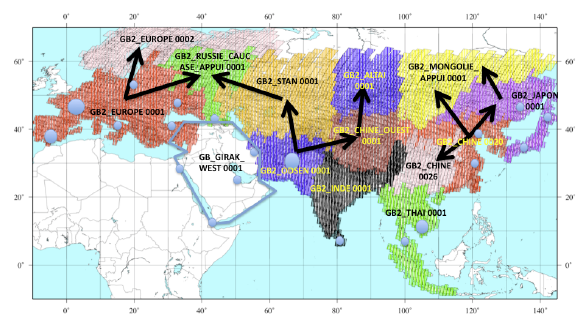
Fig. 1 : history of the processing of blocks on Eurasia. Arrows show how these blocks were merged to get a continental block.